Question: Describe this figure in one sentence.
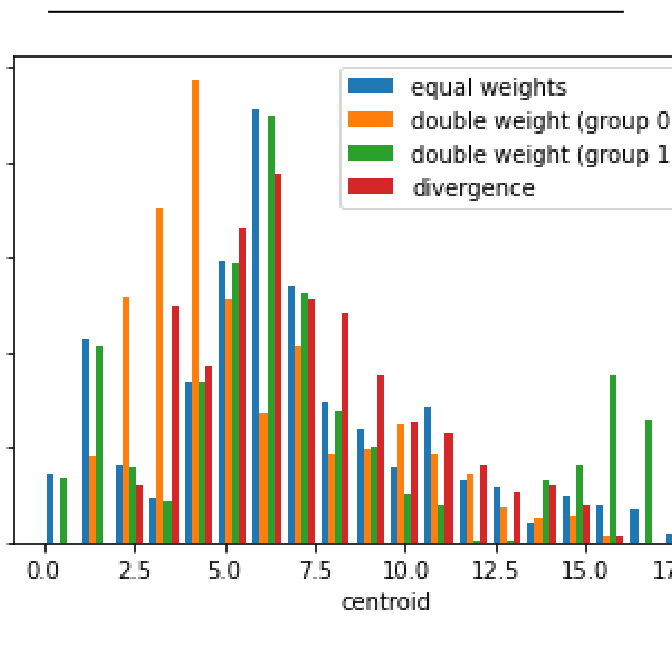
Answer: Distributions of prediction centroids on UTKFace